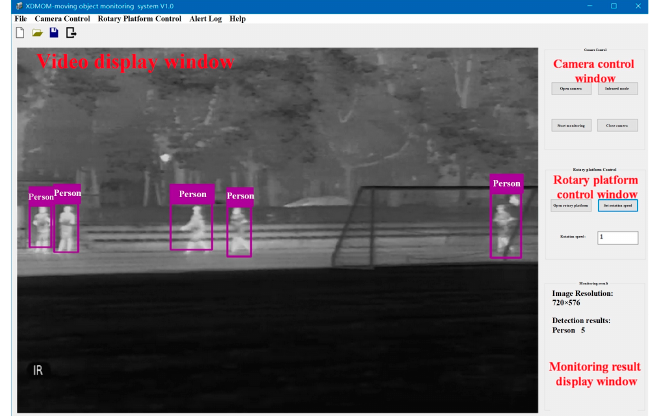
Figure 4. Software of the novel system in infrared mode.